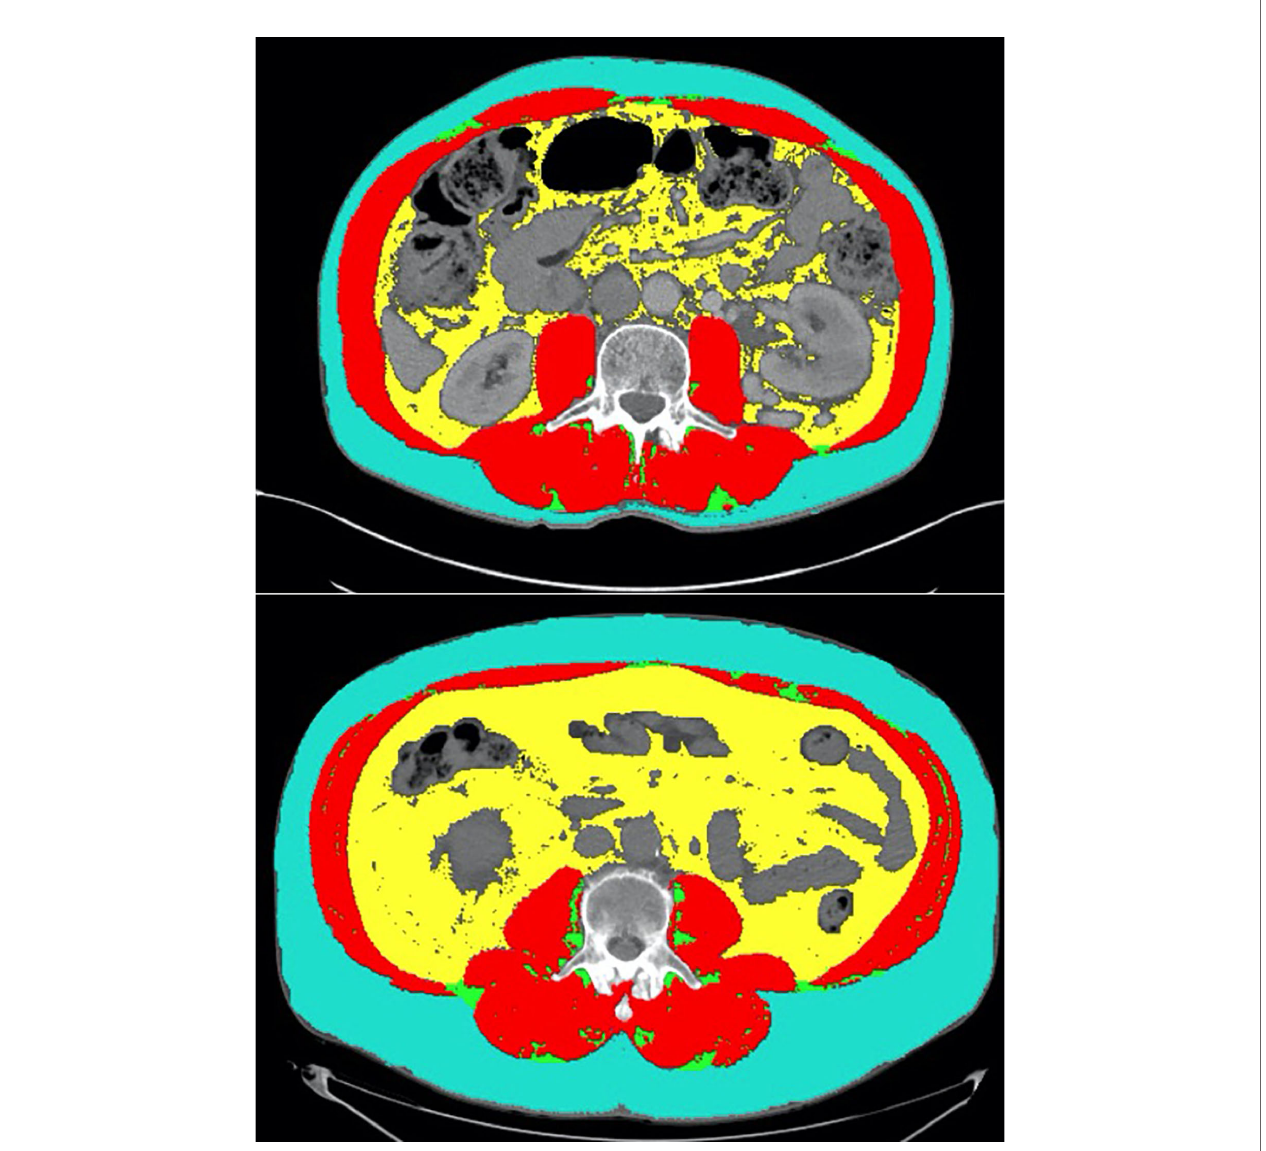
FIGURE 4 | Representative CT segmentation results from two patients with similar SMI but disparate attenuated SM mean. The fi rst patient (top panel) had an SMI of 52.48 and an attenuated SM mean of 41.45 (high). He had a partial response on treatment with anti-PD-1 monotherapy and had remained progression free for over 9 months at the time of last follow-up. The second patient (bottom panel) had a SMI of 59.38 and an attenuated SM mean of 24.97 (low). This patient had progressive disease as his best radiographic response to anti-PD-1